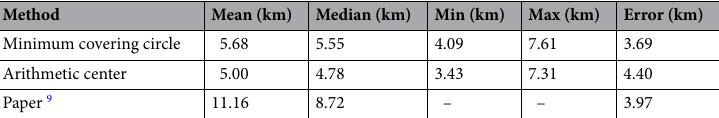
Table 2. Comparison of service area estimation